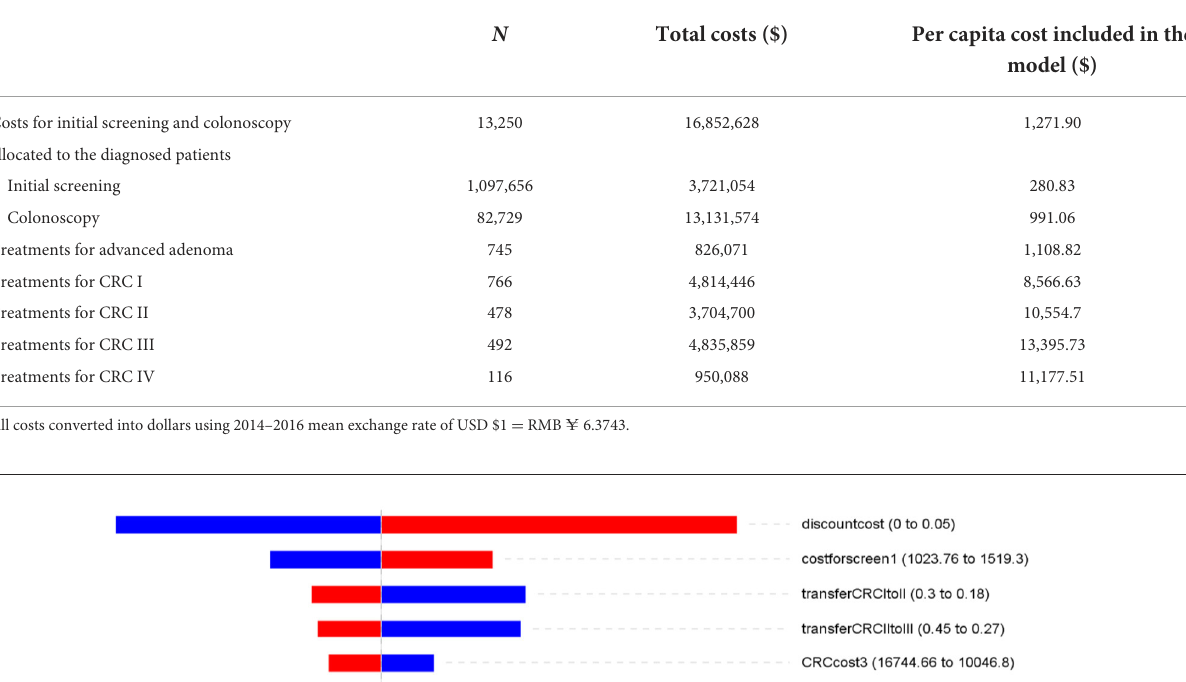
TABLE 3 Costs for SHcsp and input costs in the Markov model.